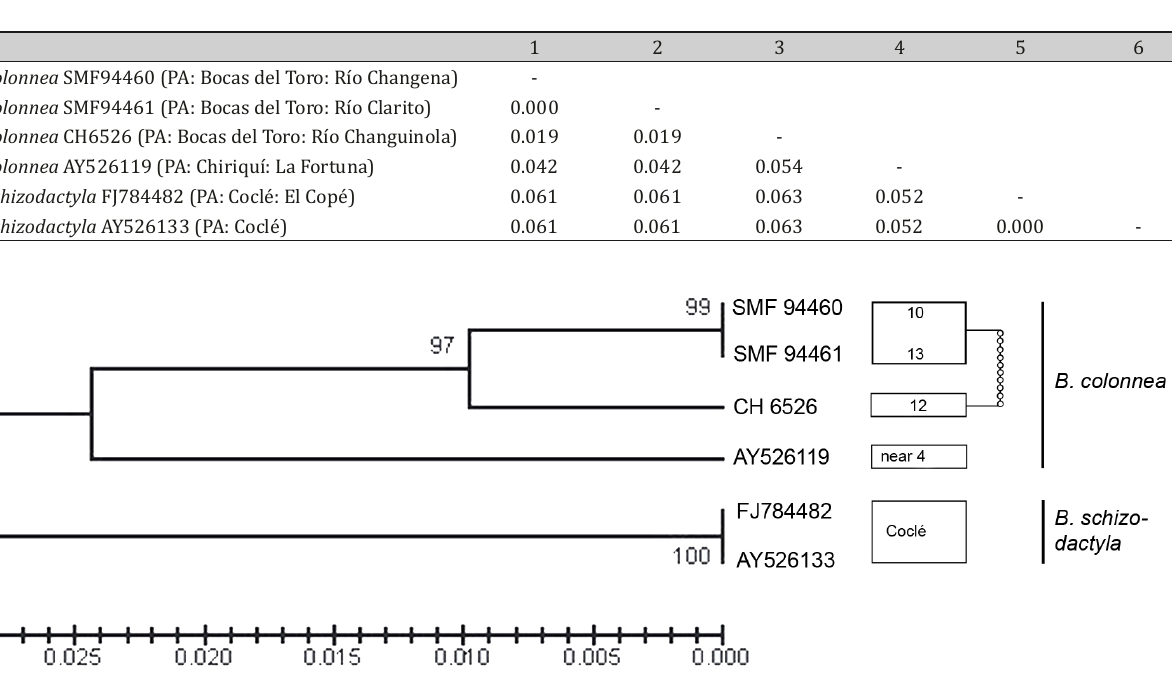
Bolitoglossa colonnea B. schizodactyla , with as an outgroup, and